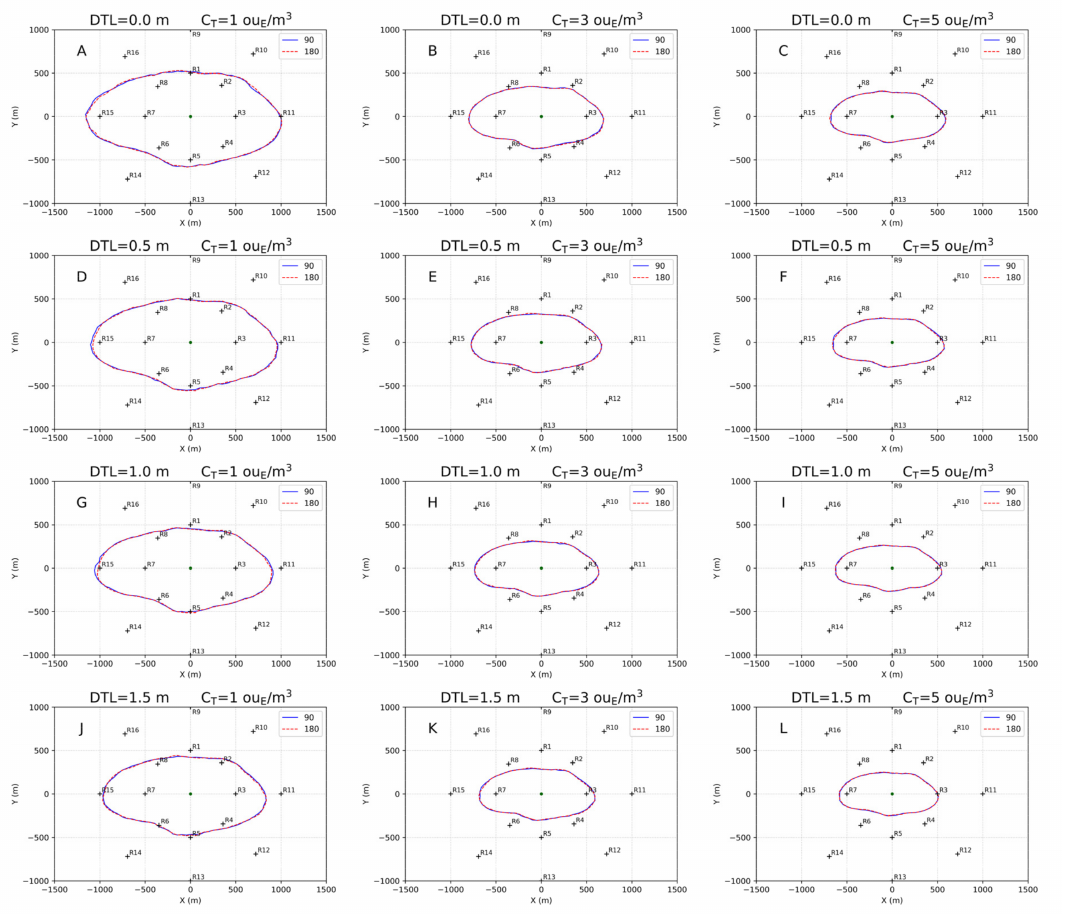
Figure 10. Tank L10_W9. Separation distances calculated for the base case (top row) and as a function of the tank orientation and DTL of 0.5 m (second row), 1.0 m (third row) and 1.5 m (bottom row). Concentration thresholds are 1 ouE/m 3 (left column), 3 ouE/m 3 (central column) and 5 ouE/m 3 (right column). The dark green circle represents the centroid of the sources, while the black crosses represent the discrete receptors. ( A ): DTL = 0.0 m, C T = 1 ouE/m 3 . ( B ): DTL = 0.0 m, C T = 3 ouE/m 3 . ( C ): DTL = 0.0 m, C T = 5 ouE/m 3 . ( D ): DTL = 0.5 m, C T = 1 ouE/m 3 . ( E ): DTL = 0.5 m, C T = 3 ouE/m 3